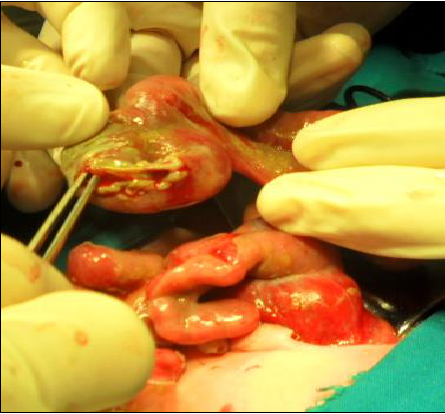
Figure 2: Intraoperative view of antenatally devel- oped perforation of the dilated proximal